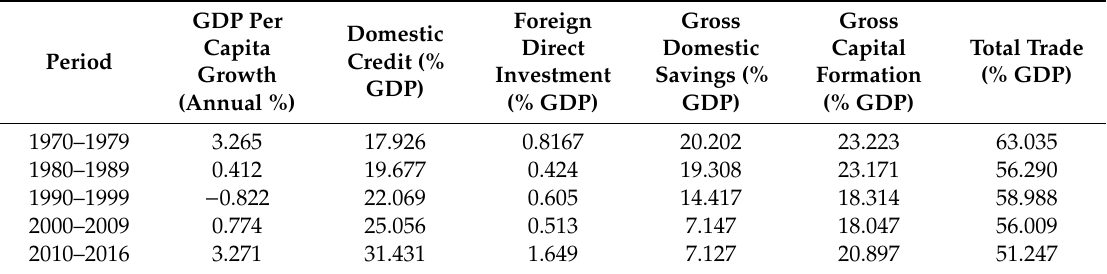
Table 1. Kenya’s macroeconomic performance